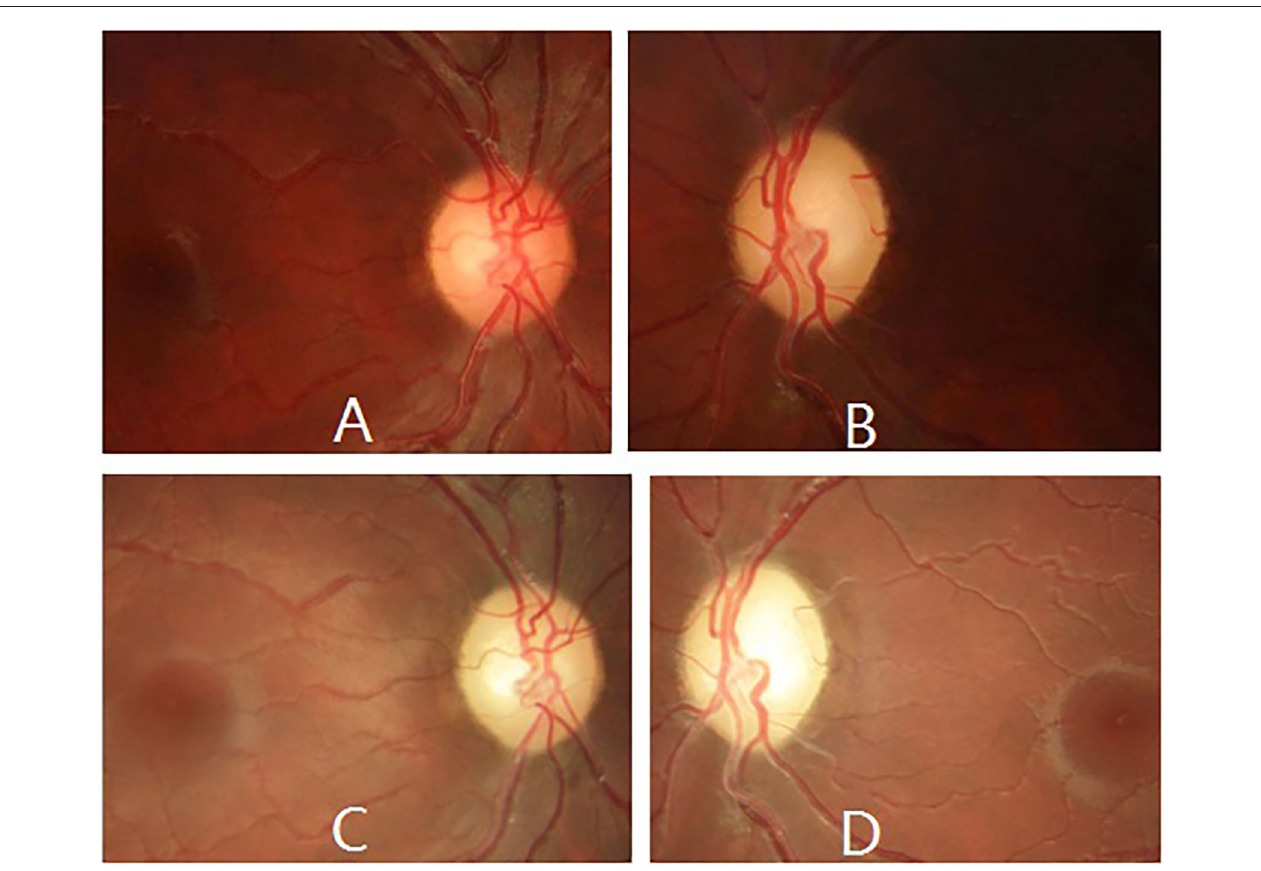
FIGURE 3 | Ophthalmic manifestations of m.13513G > A mutation-related LHON during follow-up. Fundus photography revealed temporal optic disc was pale in both eyes 2 weeks later (A,B) , and pale optic disc in both eyes 4 years later (C,D)